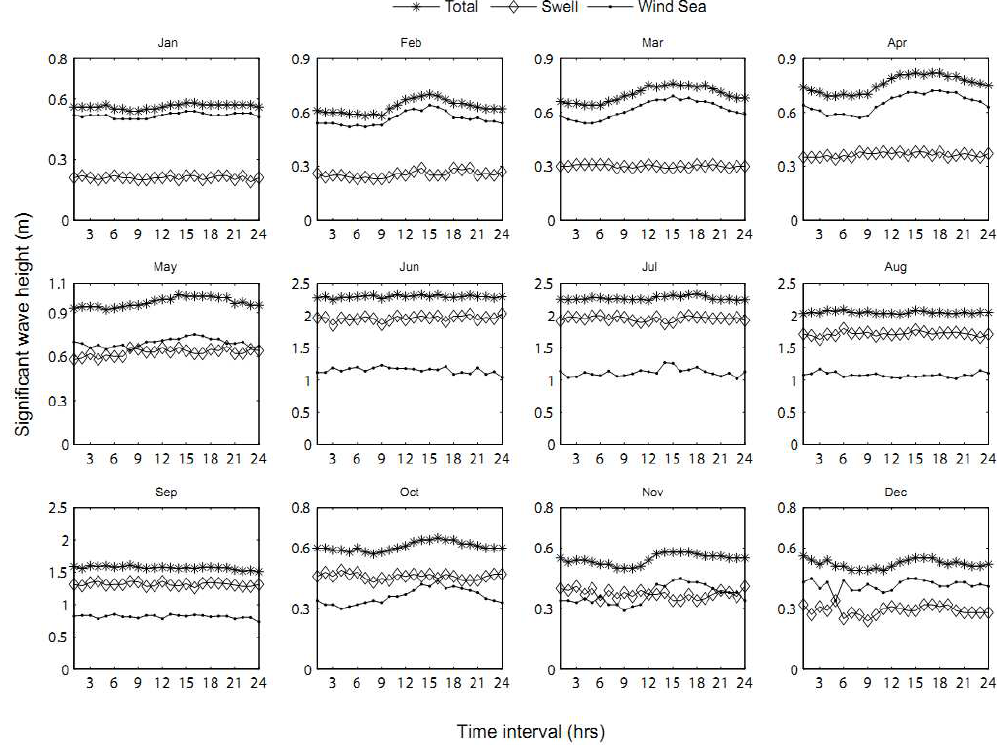
Fig. 2. Hourly variation of monthly average significant wave height during 2011, in UTC. Figure 2: Hourly variation of monthly average significant wave height during 2011 in UTC 478